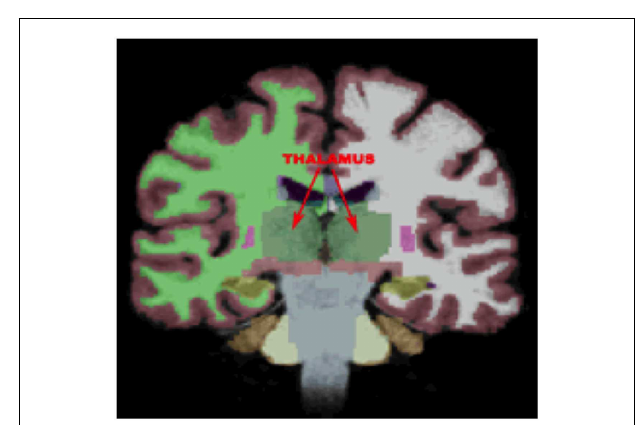
FIGURE 1 | FreeSurfer output showing left and right thalamic regions of interest